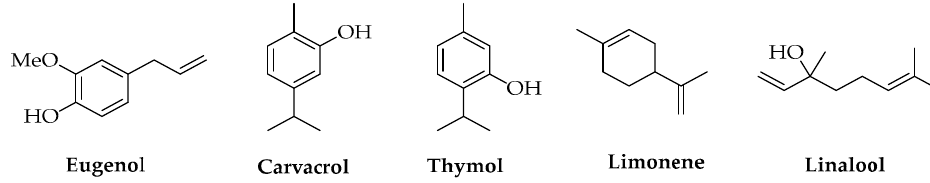
Figure 9. Chemical structures of terpenes.